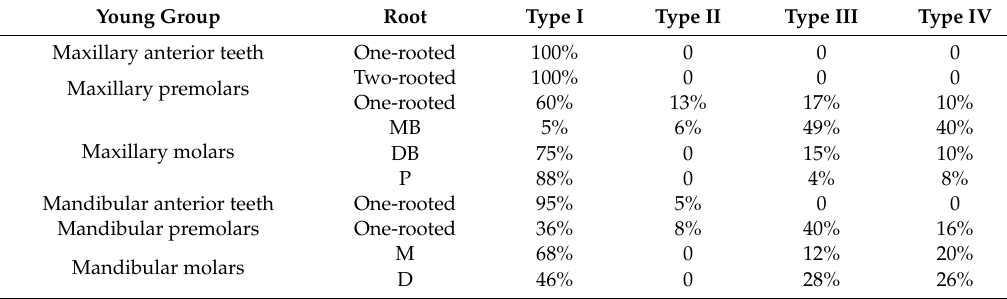
Table 3. Changes of cross-sectional root canal shape in young age group.